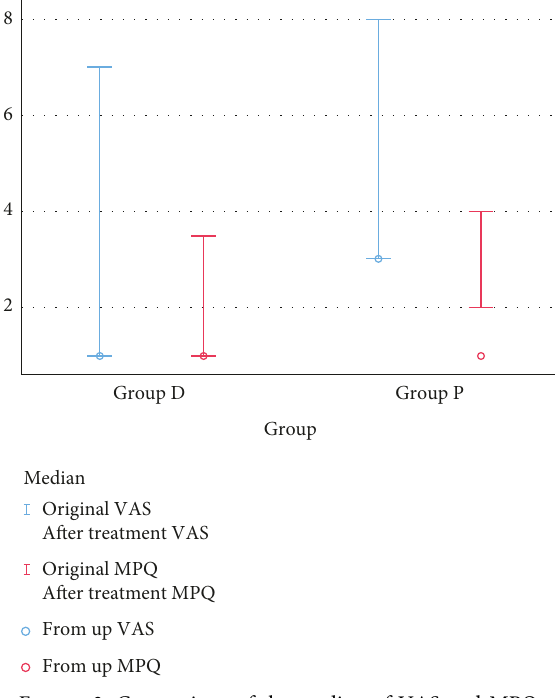
Figure 3: Comparison of the median of VAS and MPQ. Table 3: Odd other treatment’s rate and satisfactory